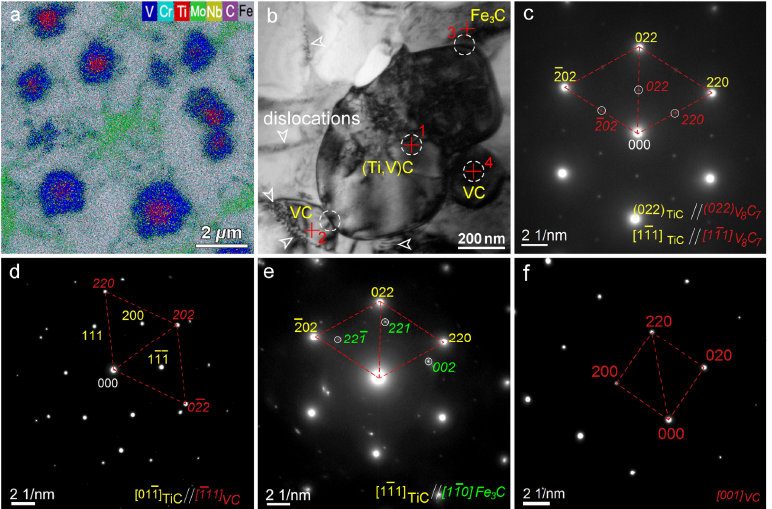
Figure 17. ( a ) EDS area mapping showing TiC/V 8 C 7 double carbides in a PTA prepared high vanadium HSS coating; ( b ) bright-field TEM image showing MC carbide cluster in the AZ with the crosses numbered for EDS; ( c – f ) related SADPs of spot 1–4, respectively, indicated by circles in ( b ) [64].